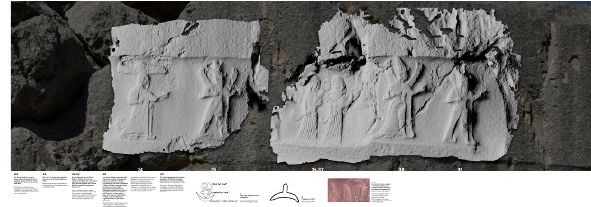
Figure 14. Visualisation system for the exhibition